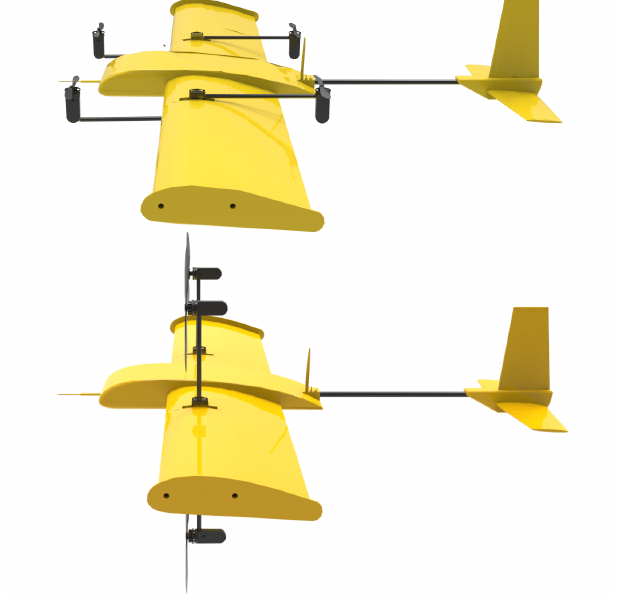
Figure 1. 3D renders of the VTOL UAV both in copter mode (top) and plane (bottom)